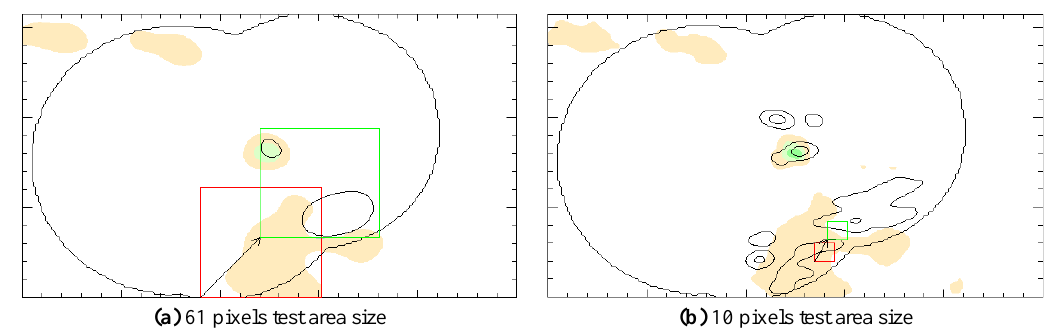
Fig. 2. Two examples of minimization vector computation for the largest test area (a) and smallest test area (b) . The shaded area is the NWP rainfall field and the black contour is the observed rainfall field from the radar. Different shapes are observed in these images due to DCT low-pass filter. The red box is the model test area whereas the green box is the observation test area which minimizes the cost function. Consequently, the displayed vector is shift-vector for this test area.